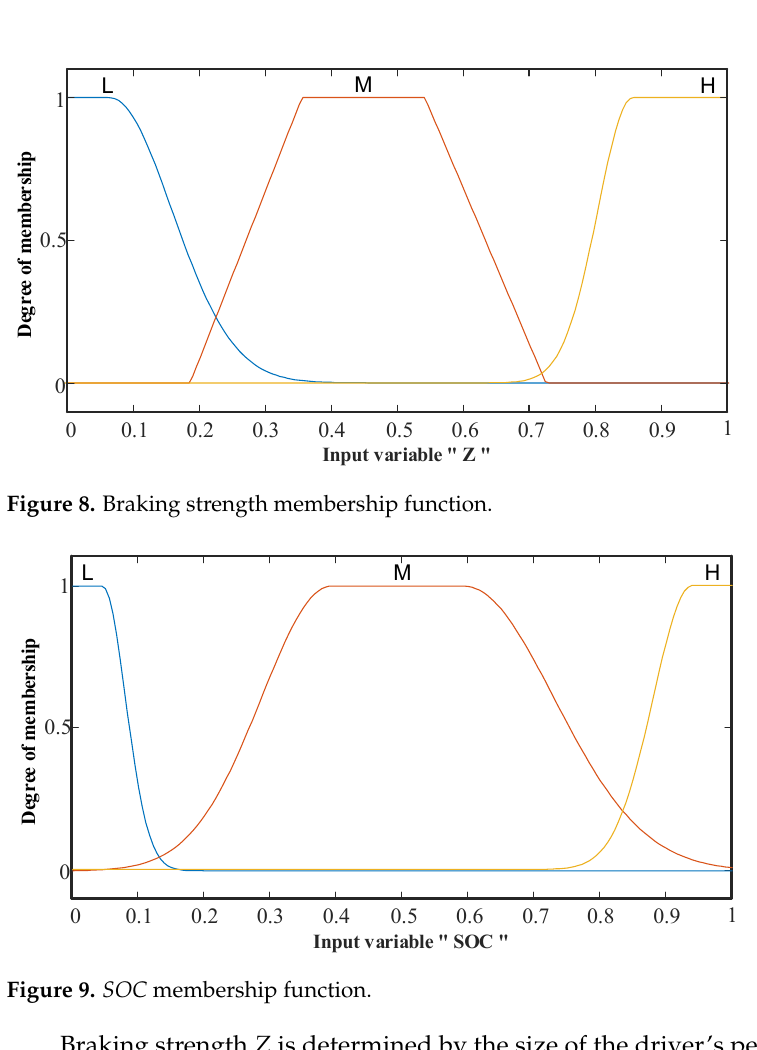
Figure 10. Regenerative braking ratio membership function.